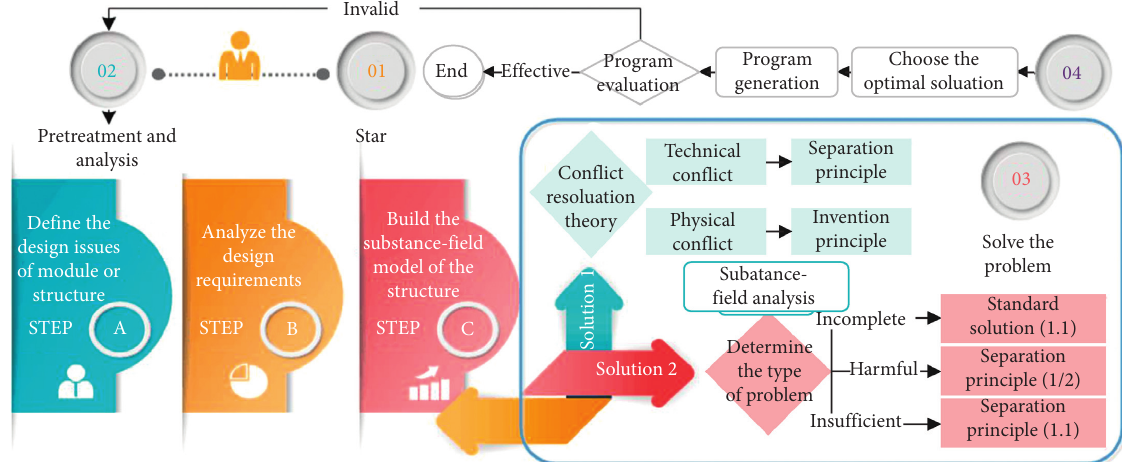
Figure 4: Design process of core system based on TRIZ conflict resolution theory—substance-field